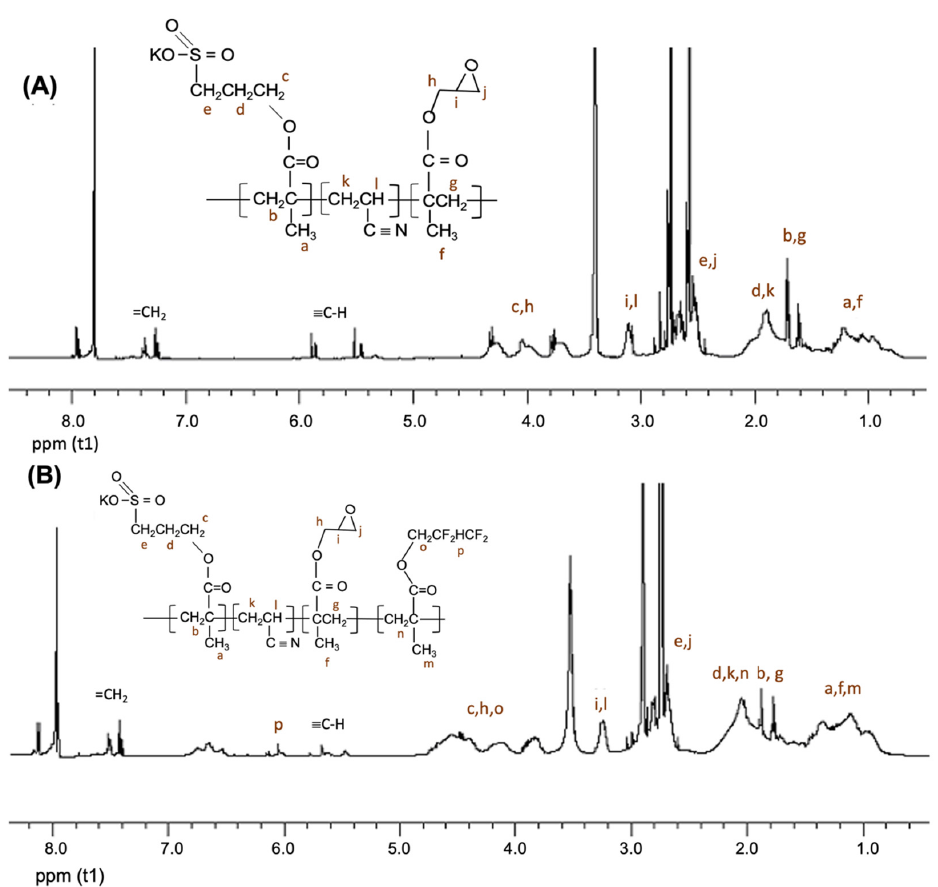
Figure 9. 1H NMR spectra of ionomers formed from the S0-10 ( A ) and S20-10 ( B ) systems after UV- irradiated polymerization for 6 h. UV-irradiated polymerization for 6